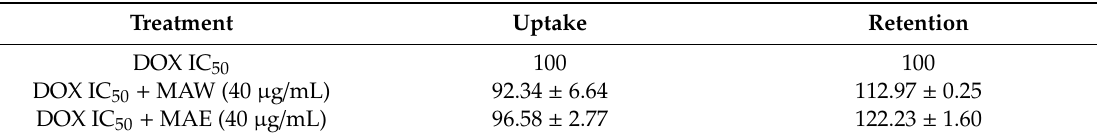
Table 3. E ff ects of M. aquifolium water and ethanol extracts on the uptake and retention of doxorubicin in A549